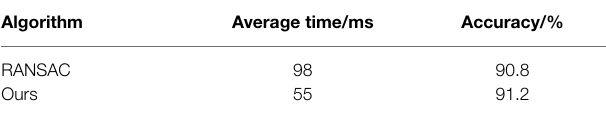
TABLE 2 | Performance comparison of the fitting algorithms.